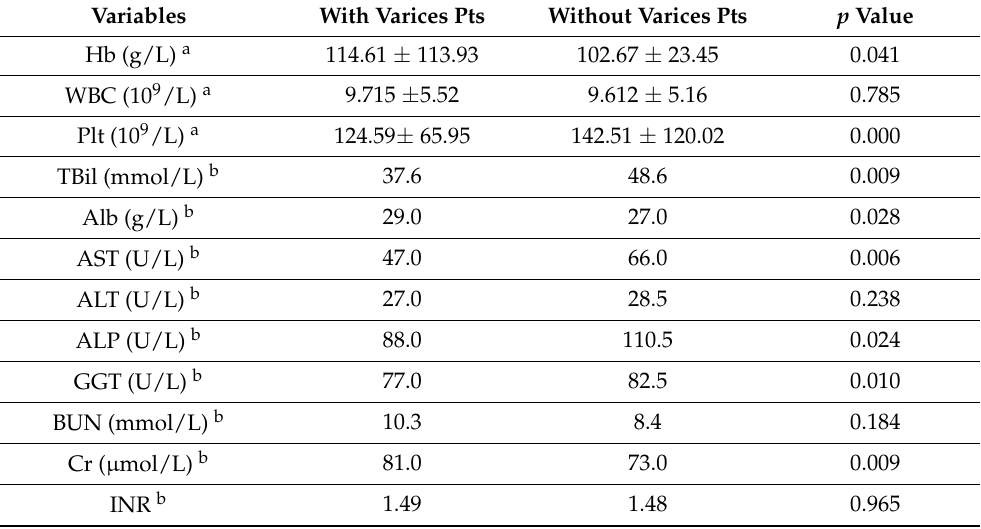
Table 3. Values of laboratory analysis and scores in relation to the presence of esophageal varices.